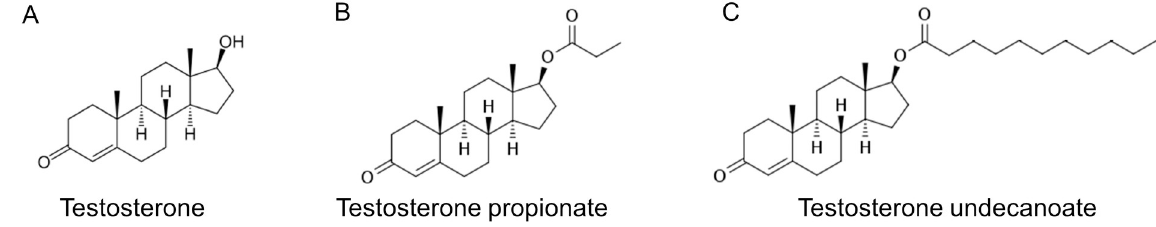
Fig 1. Structure of testosterone (A), testosterone propionate (B), and testosterone undecanoate